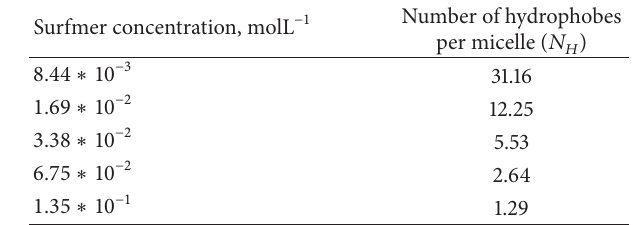
Table 7: Values of 𝑁 𝐻 as a function of surfmer concentration.